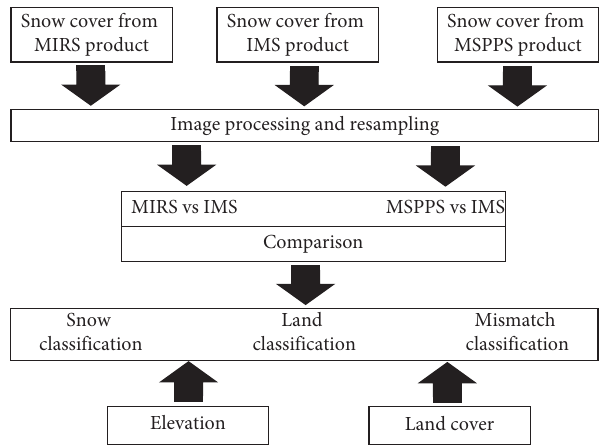
Figure 2: Flow chart showing the overall comparison process of MIRS and MSPPS with IMS snow cover and further analysis of elevation and land cover effects on snow